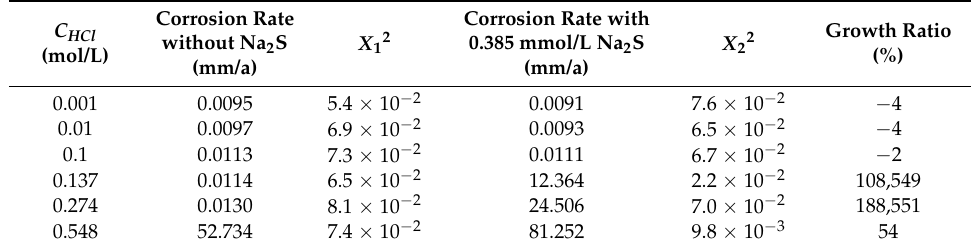
Table 1. Corrosion rates of 2205 DSS in different concentrations of HCl solution with or without Na 2 S at 90 ◦